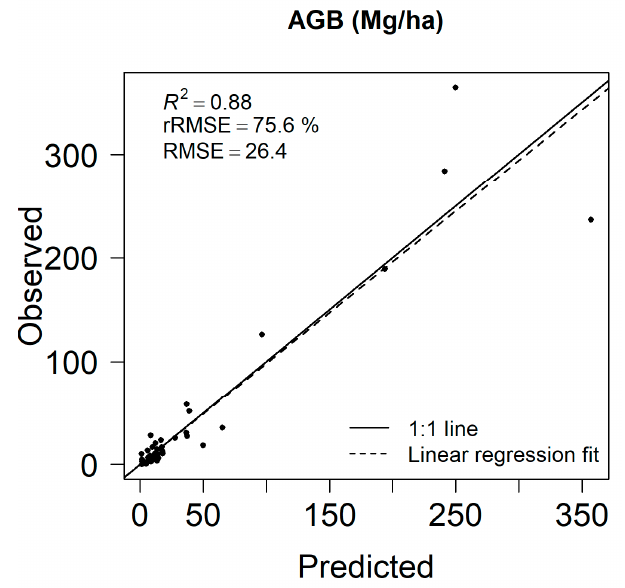
Figure 3. Airborne laser scanning- (ALS)-predicted vs. field-observed AGB based on leave-one-out cross-validation.